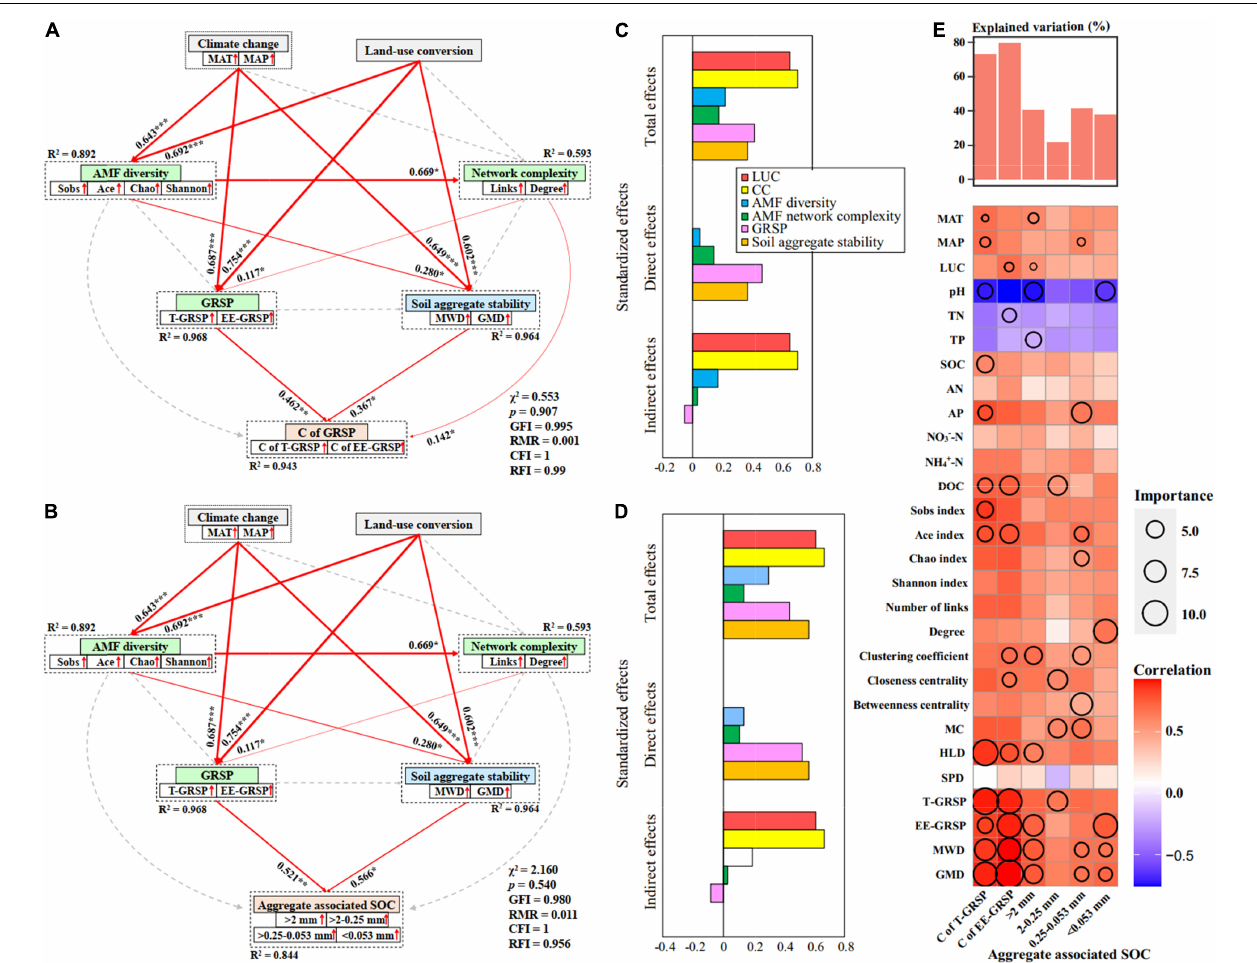
FIGURE 8 | Structural equation model analysis (SEM) that examining the effects of CC and LUC on the C concentration of GRSP (A) and soil aggregate-associated SOC concentration (B) via pathways of AMF diversity, AMF network complexity, GRSP and soil aggregate stability in cropland and fallow land. Red arrows indicate positive relationships. Continuous arrows and dashed arrows indicate significant relationships and non-significant relationships, respectively. The arrow width is proportional to the strength of the relationship. Double-layer rectangles represent the first component from the PCA conducted for AMF diversity, AMF network complexity, GRSP and soil aggregate stability. The red symbol “ ↑ ” indicates a positive relationship between the variables and the first component from the PCA. The numbers adjacent to the arrows are standardized path coefficients, which reflect the effect size of the relationship. The proportion of variance explained ( R 2 ) appears alongside each response variable in the model. The final models yielded good fits to the data; Standardized effects of CC, LUC, AMF diversity, network complexity, GRSP, and soil aggregate stability on the C concentration of GRSP (C) and soil aggregate-associated SOC concentration (D) ; and (E) random forest model estimating the effects of each environmental variable on the C concentration of GRSP and soil aggregate-associated SOC concentration.